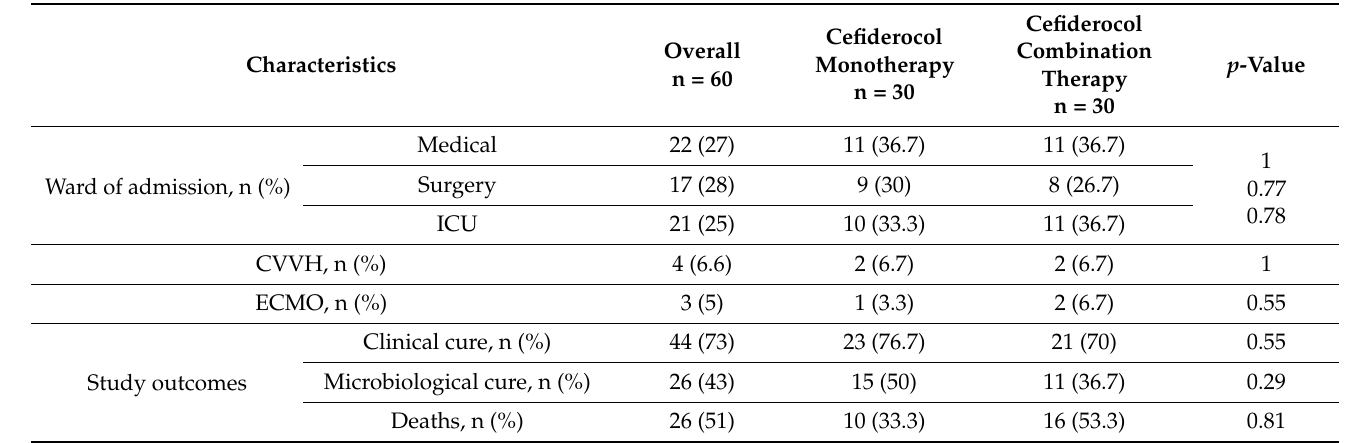
Legend for Table 3: n = number, % = percentage, and IQR = interquartile range.